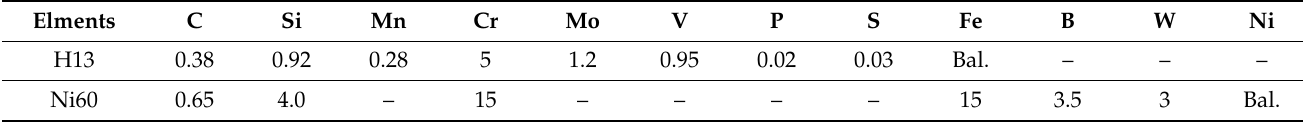
Table 1. Chemical composition of substrate and coating